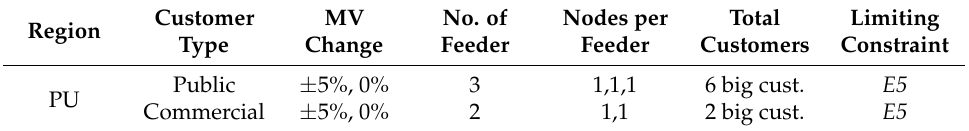
Table 5. Test network parameters and their limiting constraints for public and commercial customers.